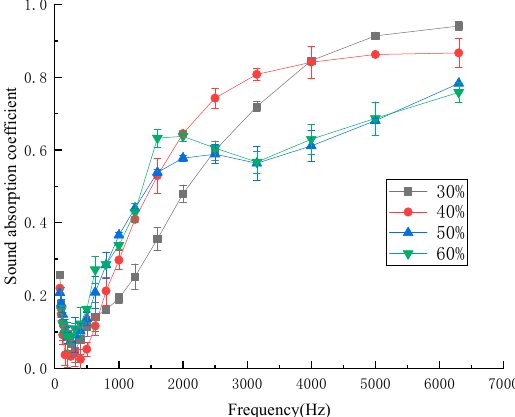
Figure 6. Sound-absorption coefficient with different mass fractions of kapok fiber.